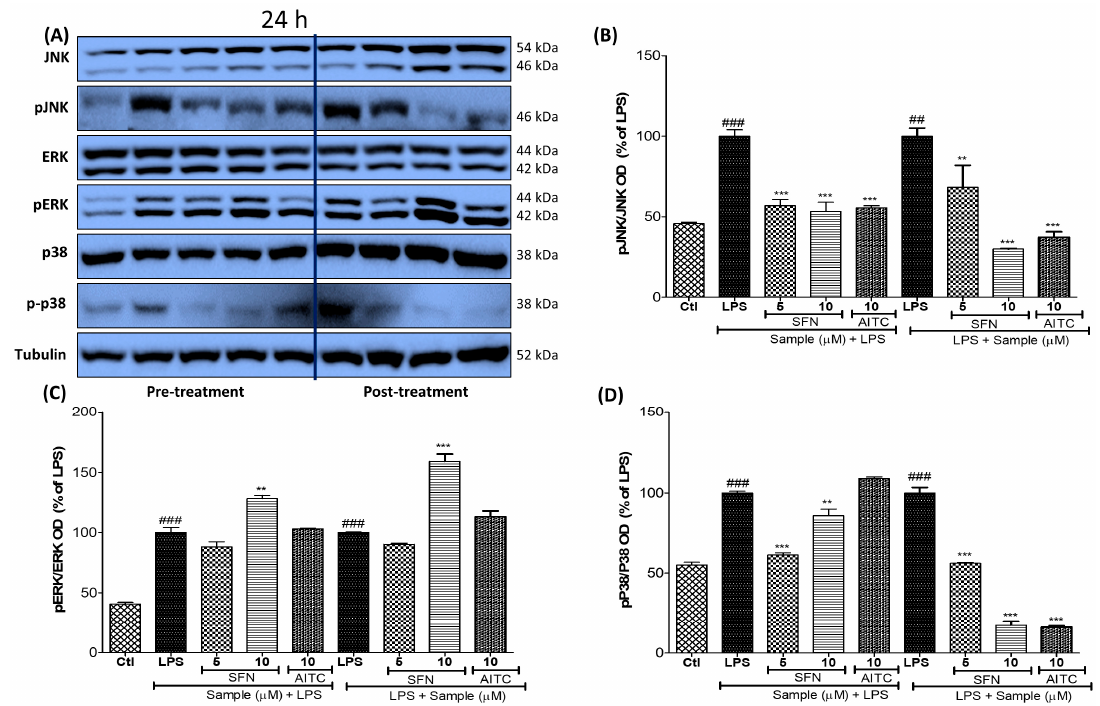
Figure 5. SFN pre-treatment and post-treatment modulated MAPK effector signaling in BV2 microglial cells subjected to chronic LPS (100 ng/mL) activation. The cells were pre-/post-treated with SFN or AITC, and MAPK modulation was observed after 24 h of LPS activation. ( A – D ) Protein expression of pJNK/JNK, pERK/ERK, and p-p38/p38. α -Tubulin was used as a loading control. All data are presented as the mean ± standard error of the mean of three independent experiments. ** p < 0.01 and *** p < 0.001 indicate significant differences compared with LPS treatment alone; ## p < 0.01 and ### p < 0.001 indicate significant differences compared with the untreated control group. Ctl—untreated control cells; LPS—cells treated with lipopolysaccharide only.